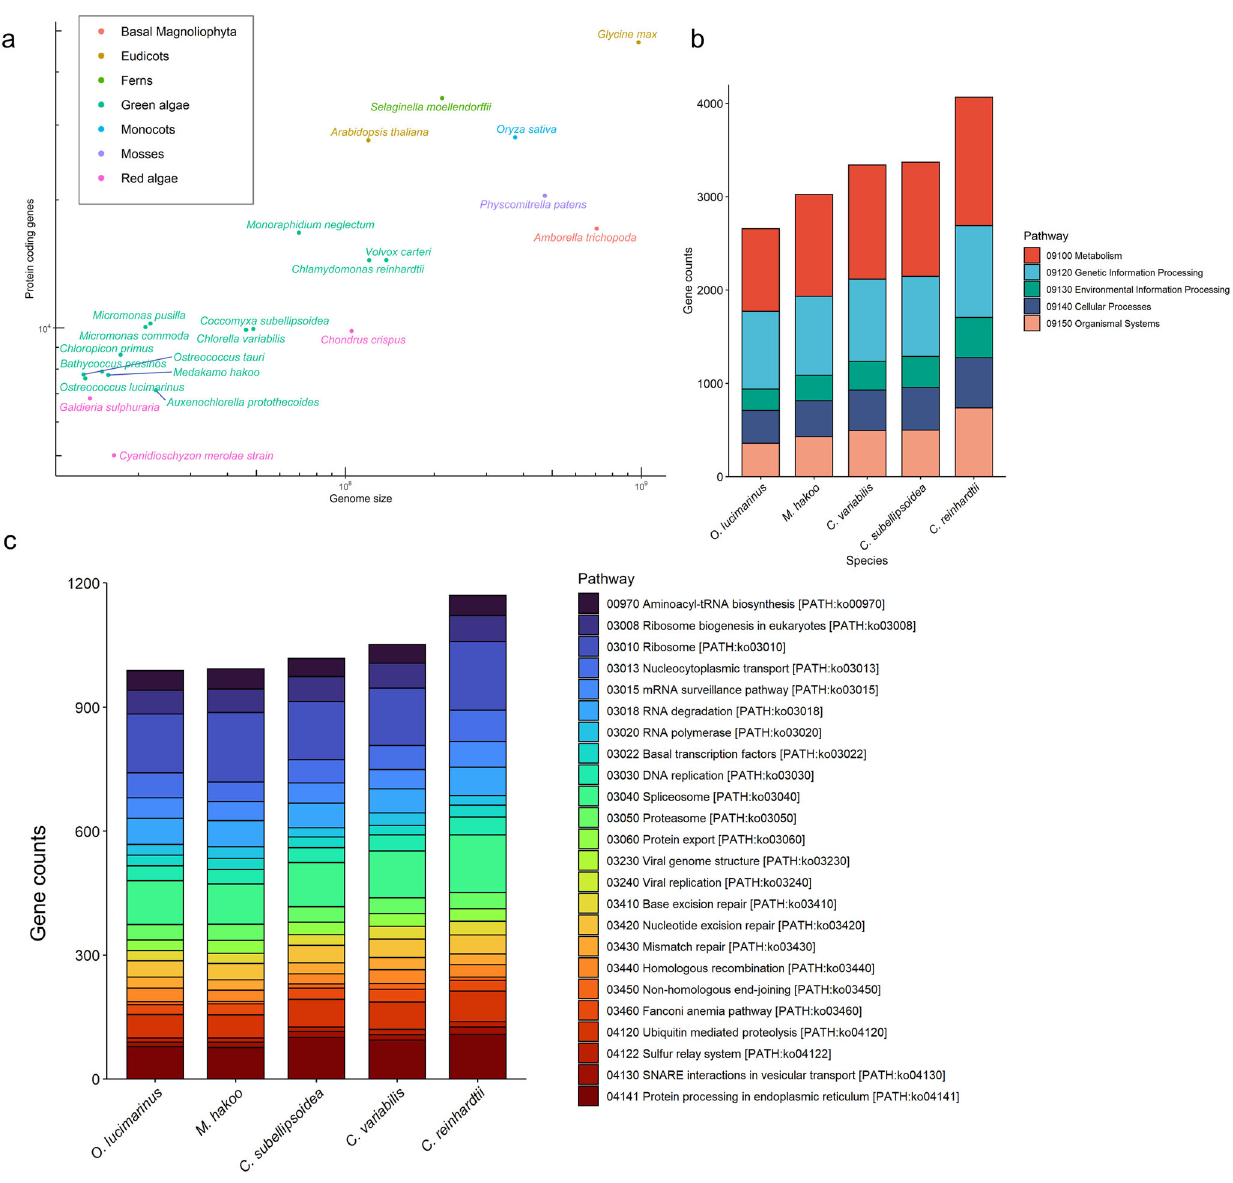
Fig. 4 Gene number and composition of the Medakamo hakoo genome. a Plot of the protein-coding genes and the total genome size of plants. b Number of green algae genes belonging to each KEGG Orthology category. The fi rst-level classi fi cation was used for counting genes. c Number of green algae genes belonging to the ‘ Genetic information processing ’ KEGG Orthology category. The third-level classi fi cation was used for counting